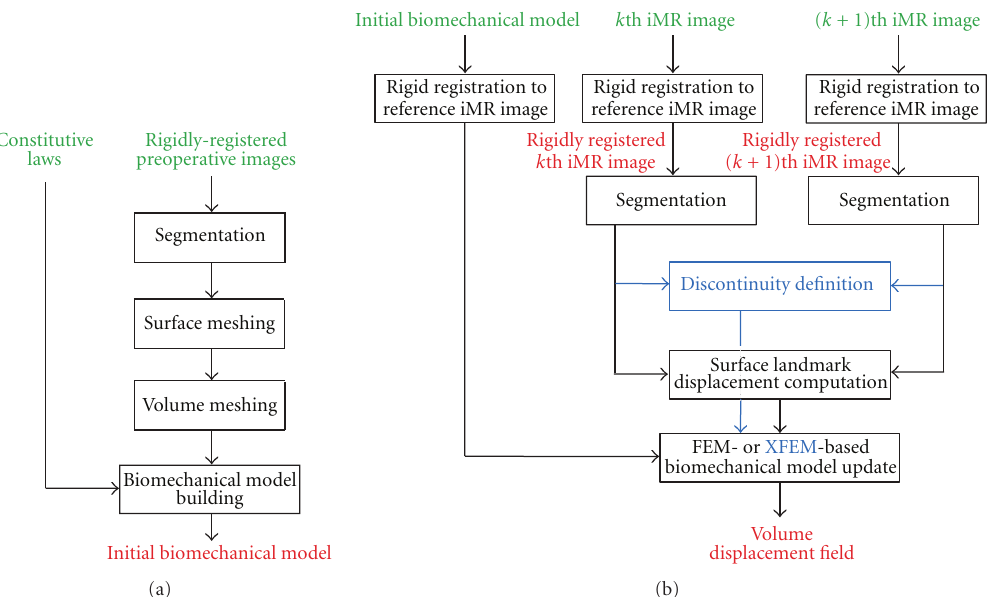
Figure 2: Detailed block diagram of the three subsystems of our serial preoperative image-update system. (a) Building of the biomechanical model from the preoperative images. (b) Calculation of the volume displacement field of the initial biomechanical model using the displacement fields of surface landmarks tracked between a pair of successive iMR images. The updated iMR images are used for validation. For each subsystem, inputs are in green, outputs are in red, and steps related to the definition and use of a discontinuity are in